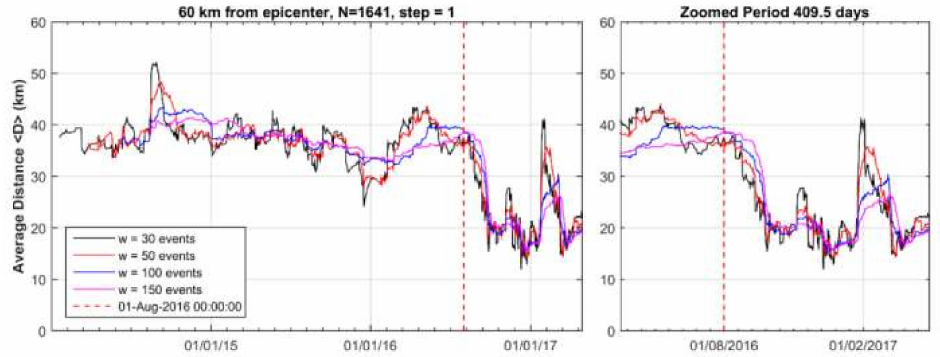
Figure 10. Time variation of the average distance, < D > , between the 2018 mainshock epicenter and earthquake (M c ≥ 2.0) epicenters during the seismicity stage BGS 1 (1 January 2014–1 August 2016)